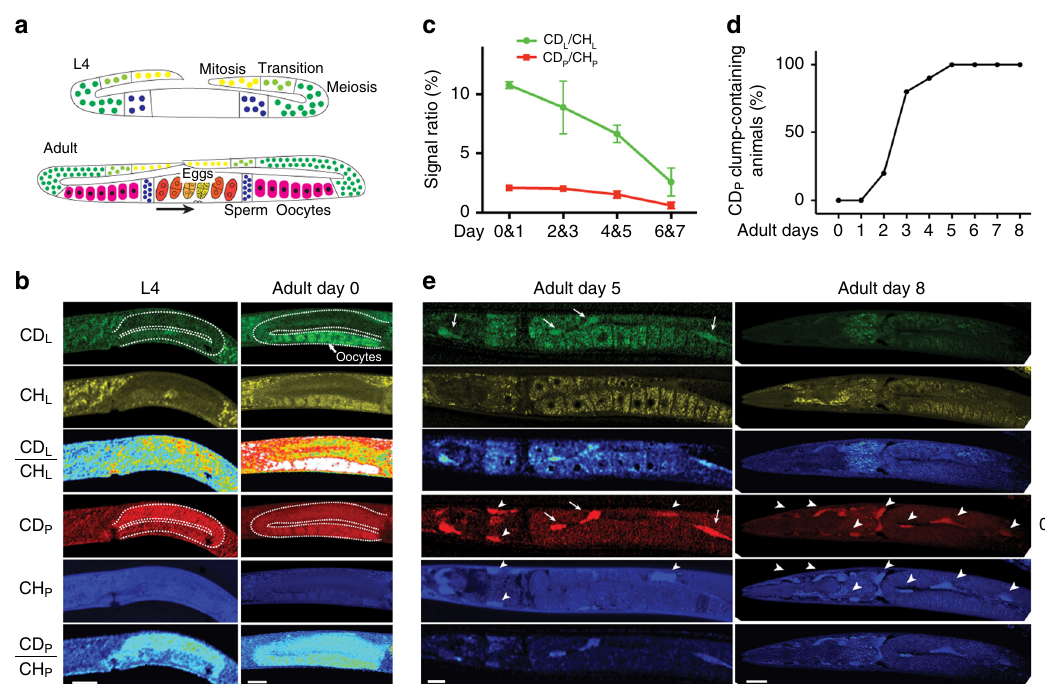
Fig. 7 DO-SRS microscopy visualizes in vivo protein and lipid metabolism simultaneously in C. elegans . a Cartoons depict germline development 66 with the following color scheme: yellow mitotic region, light green transition (early prophase of meiosis I), dark green pachytene, dark blue spermatogenesis, and pink oogenesis. In adults, a color gradient from orange to dark yellow indicates the development (arrow) from newly fertilized eggs to 32-cell embryo, which would be expelled via the vulva (triangles). b L4 animals and day 0 adults were grown on 20% D 2 O plates for 3 h before imaging (dashed outline indicates the gonad). Scale bar = 20 μ m. c Day 0 – 7 adults were grown on 20% D 2 O plates for 3 h and then imaged. Mean intensity ratios (mean ± s.d.) are shown for animals divided into four age groups. N = 10 in each group. d Day 0 – 8 adults were transferred from regular NGM plates to 20% D 2 O plates and then imaged in 3 h. The percentages of animals that showed CD signals in clumps in the body cavity and outside of the oocytes are shown; N = 8 for each time point. e SRS microscopic images of day 5 and day 8 adults after 3 h D 2 O probing. Arrows indicate newly formed lipid and protein accumulations only labeled by CD signals, whereas arrowheads indicate pre-existing mass labeled by CH signals. The color scale bars represent the scale for CD L /CH L